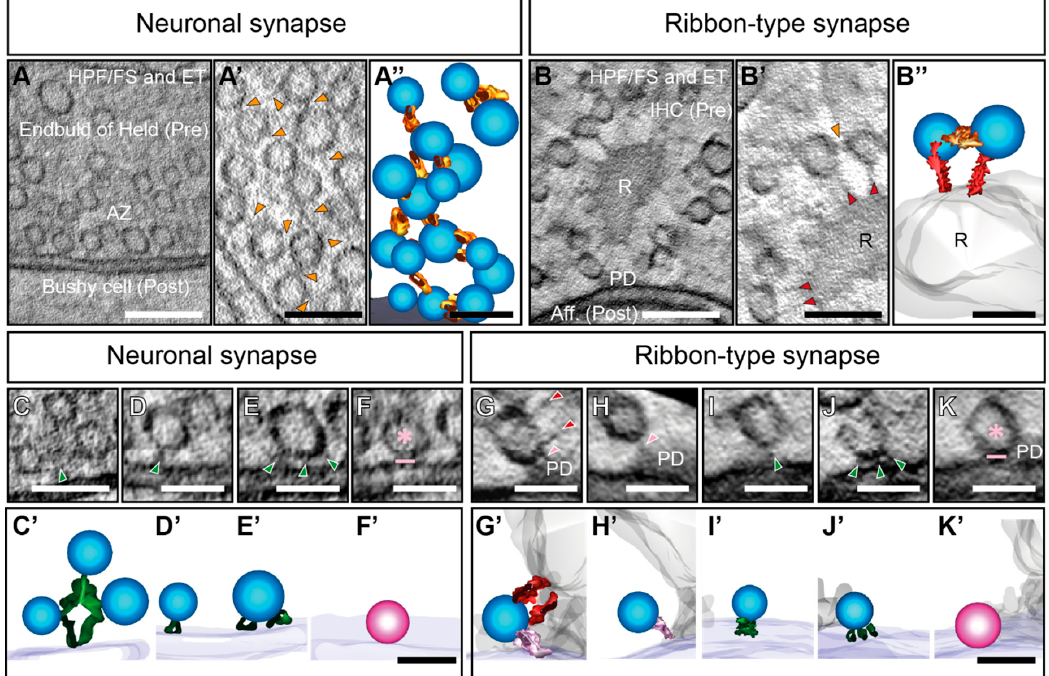
Figure 2. The diversity of filaments and corresponding vesicles at neuronal and ribbon-type synapses. ( A , B ) Virtual sections are showing overviews of a murine endbulb of Held active zone (AZ) ( A ) and IHC ribbon (R) synapse ( B ), prepared by HPF/FS. Scale bars 200 nm. Magnifications highlight ( A’ ) SV in the cytoplasm and ( B’ ) RA-SVs distal from the AZ membrane in the respective synapses. In both